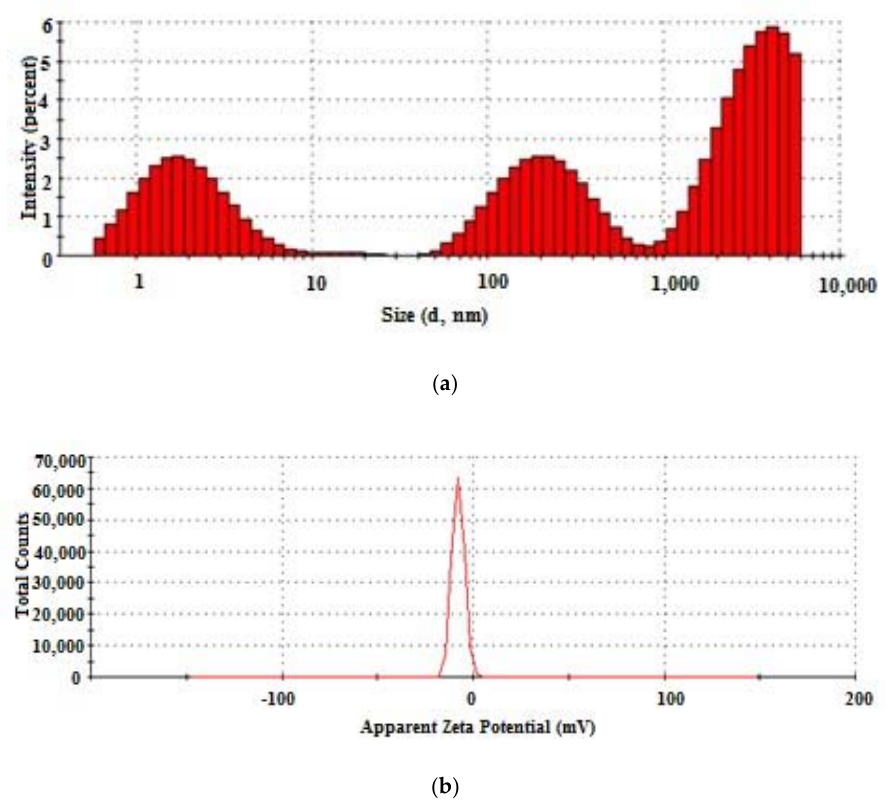
Figure 2. Histogram of particle size distribution ( a ) and zeta potential ( b ) in concentrated collagen hydrolysate.